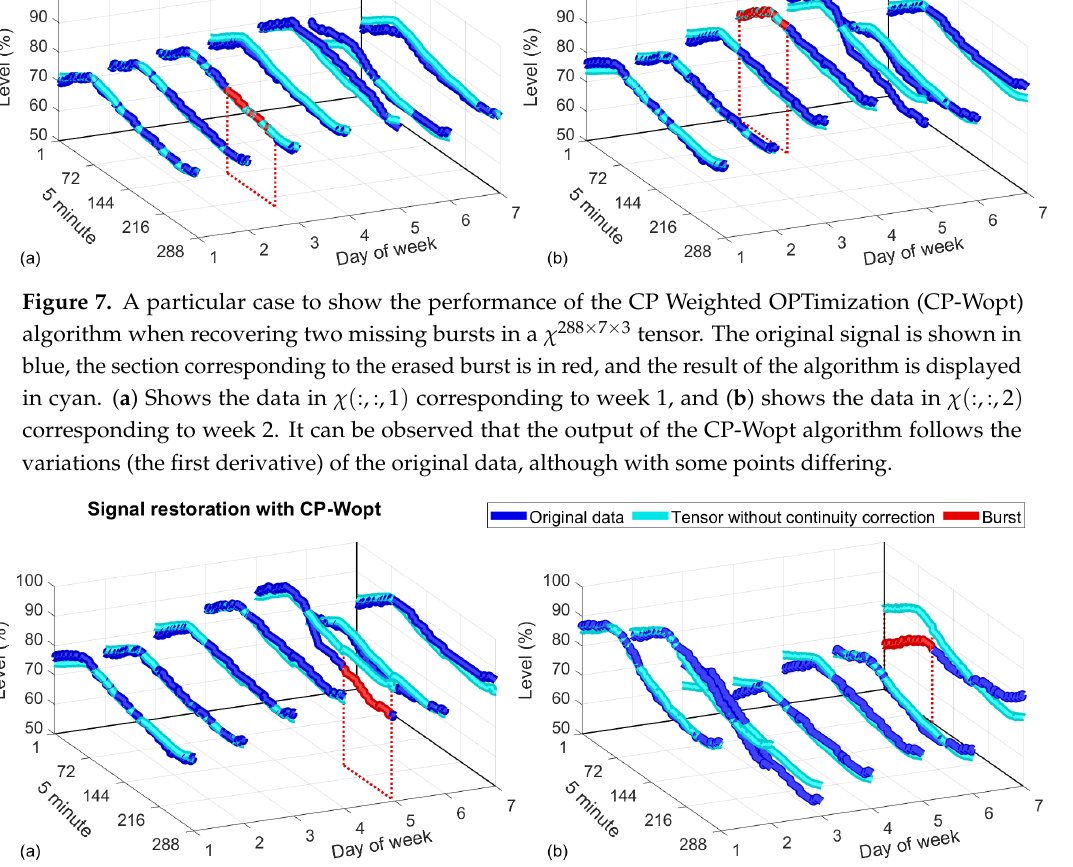
Figure 8. Representation of the offset error that the CP-Wopt algorithm sometimes performs when recovering two missing bursts in a χ 288 × 7 × 3 tensor. The original signal is shown in blue, the section corresponding to the erased burst of 100 samples is shown in red, and the result of the algorithm is shown in cyan: ( a ) shows the data in χ ( :, :,2 ) corresponding to week 2; ( b ) shows the data in χ ( :, :,3 ) corresponding to week